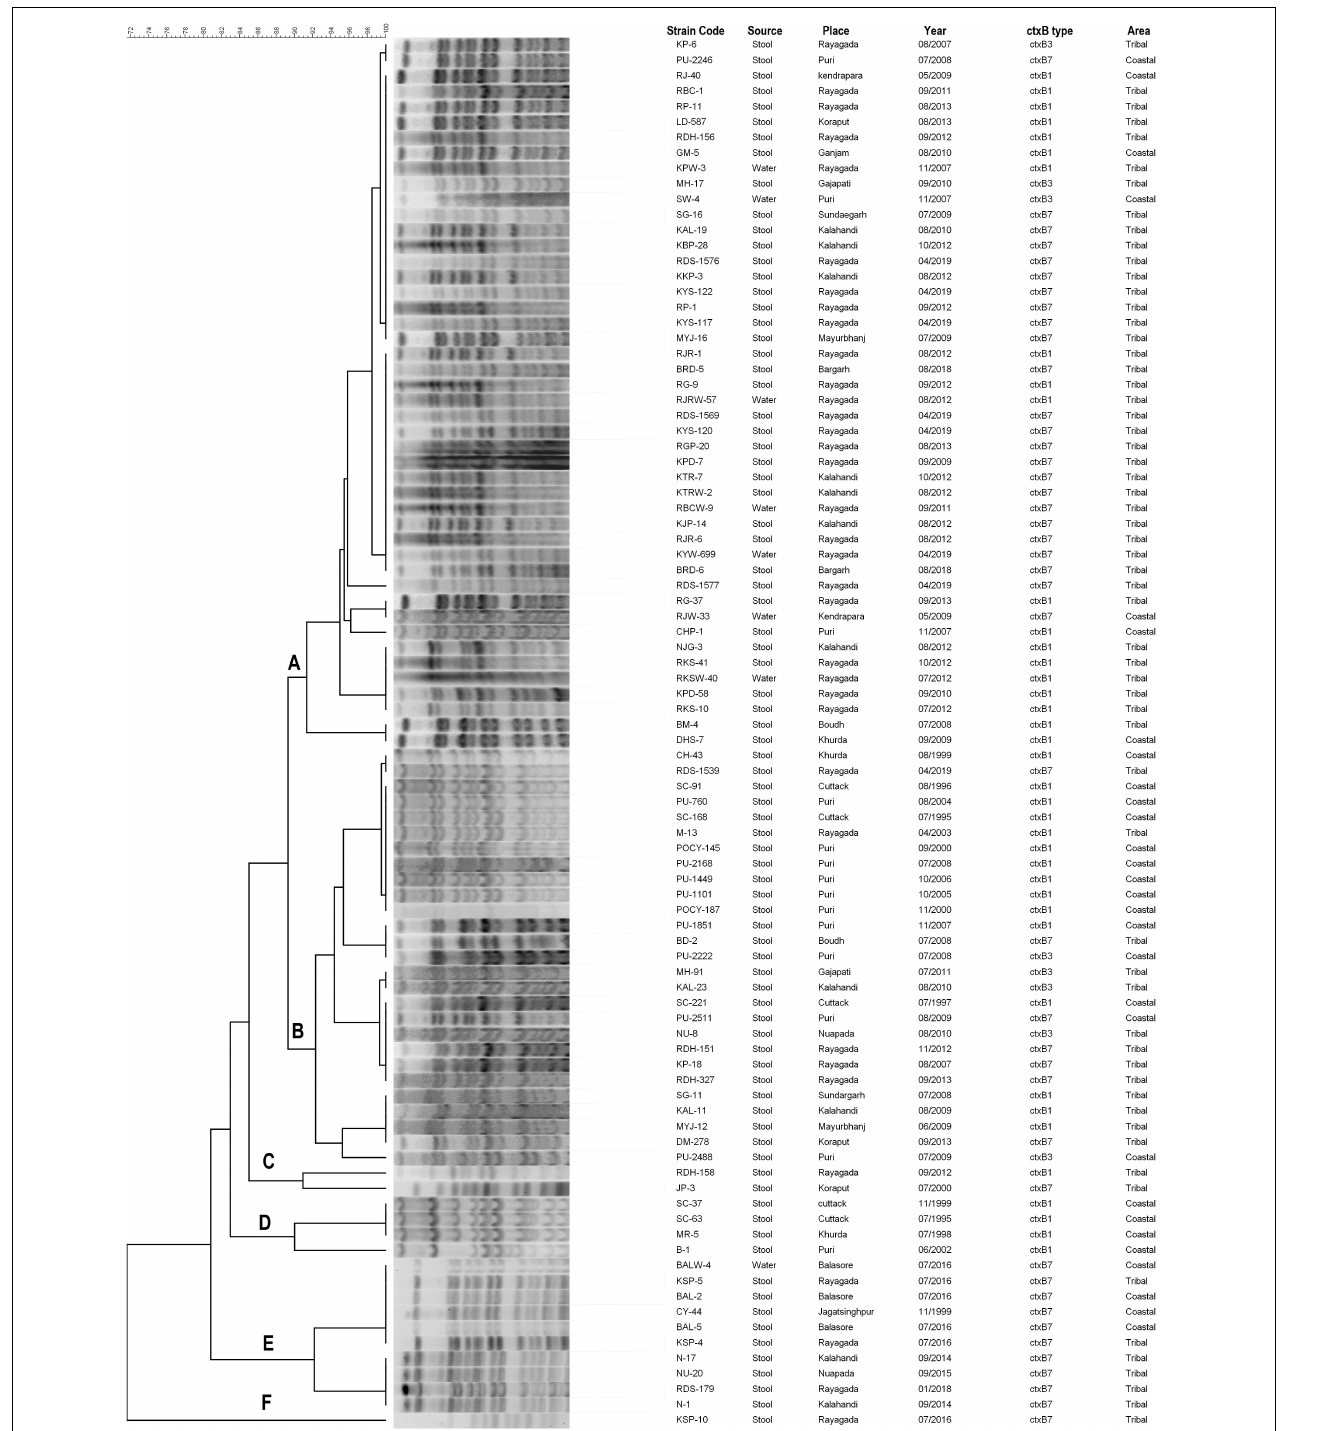
FIGURE 6 | PFGE patterns of the Not I-digested Vibrio cholerae O1 strains isolated from different districts of Odisha: 1995–2019. Capital letters means different clusters.